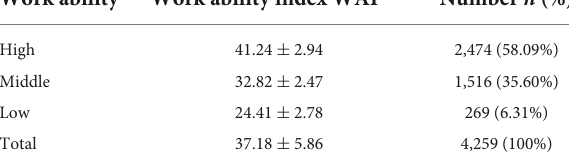
TABLE 1 Analysis of the work ability index of petroleum workers.